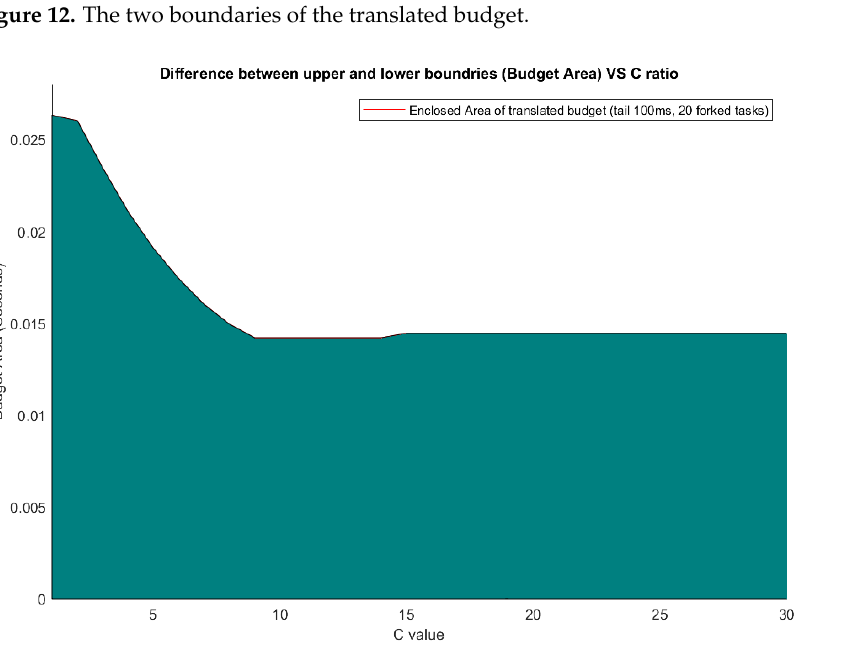
Figure 13. Translated Budget area: the enclosed area between the two